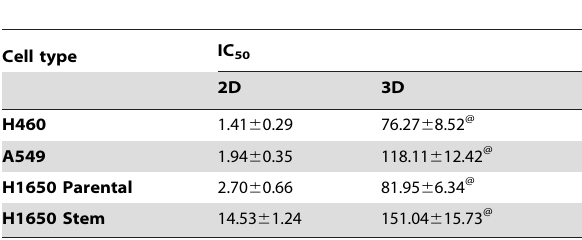
Table 1. The comparative IC 50 values of Docetaxel on H460, A549, H1650 parental and stem lung cells in 2D and 3D alginate scaffold system.